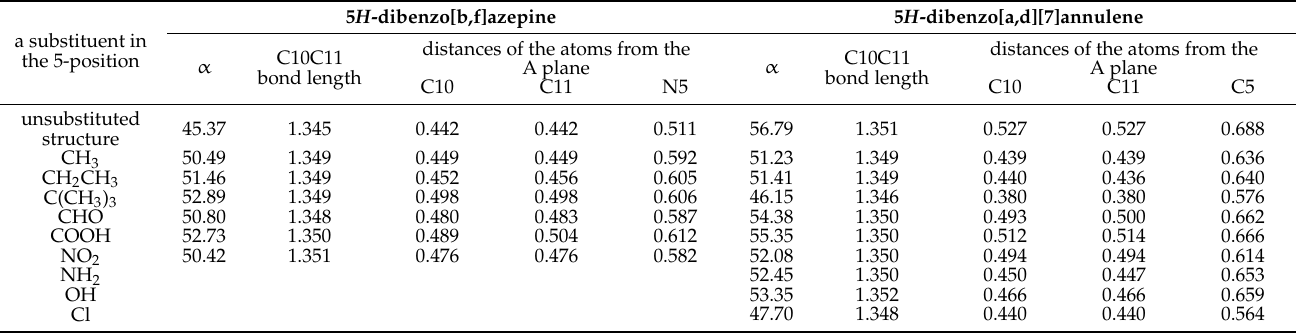
Figure 3. Correlation of the distance of the C5 or N5 atom from the A plane on the α angle on for: 5 H -dibenzo[b,f]azepine ( a ), 5 H -dibenzo[a,d][7]annulene ( b ), 10,11-dihydro-5 H -dibenzo[b,f]azepine ( c ), 10,11-dihydro-5 H -dibenzo[a,d][7]annulene ( d ). Table 3. Geometry parameters for optimized